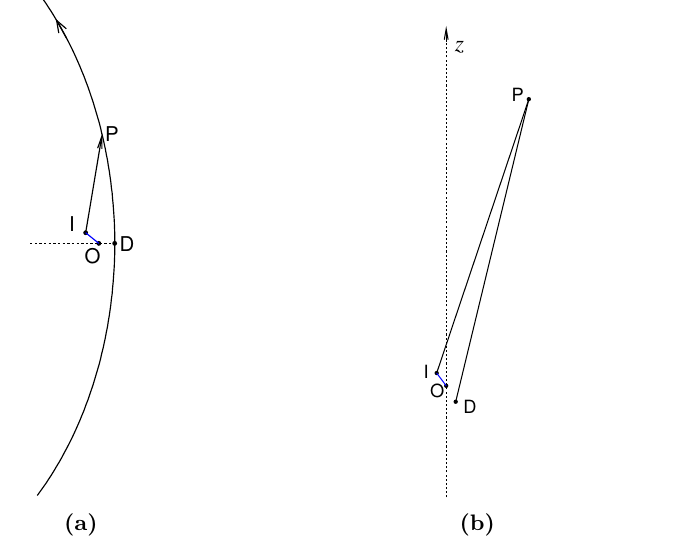
Figure 3 . Illustration of a track trajectory viewed in the (a) x { y and (b) r { z planes, where O is the origin, I is the interaction point, P is the tau decay point, and D is the track perigee with respect to O .